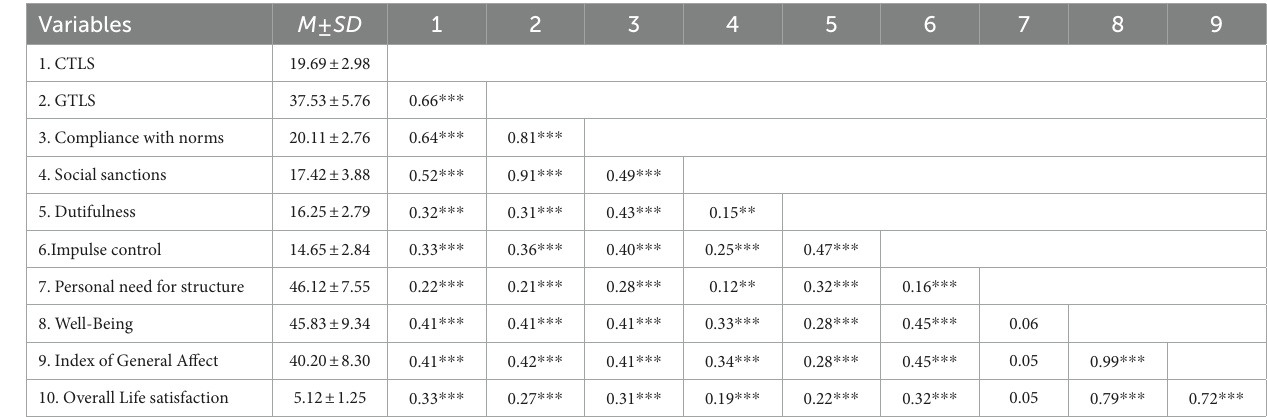
TABLE 4 Criterion validity ( N = 512).